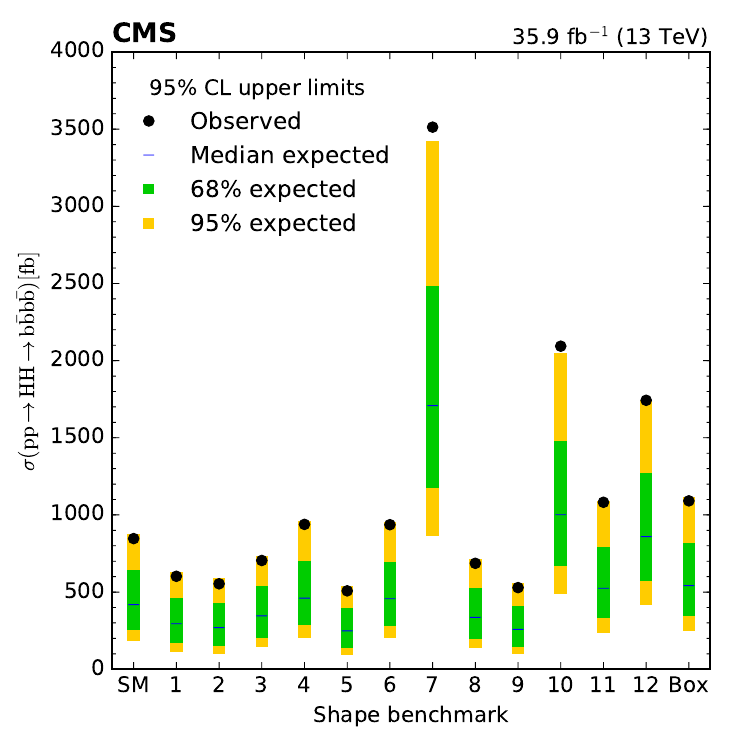
Figure 9 . The observed and expected upper limits at 95% CL on the (cid:27) (pp ! HH ! bbbb) cross section for the 13 BSM models investigated. See table 1 for their respective parameter values.